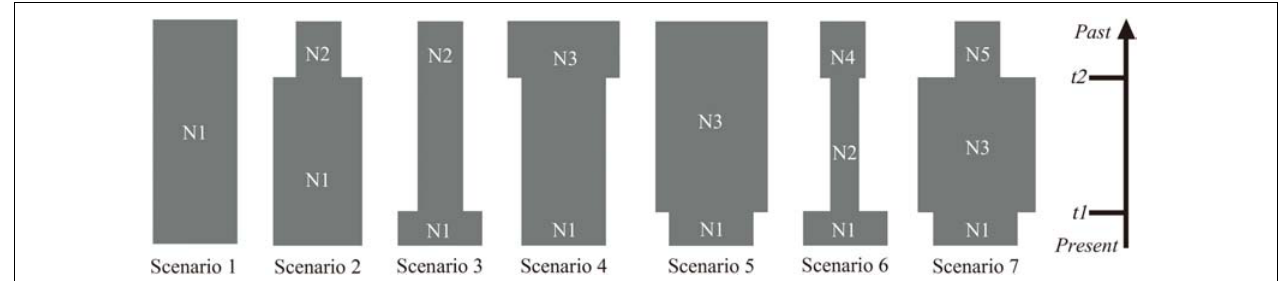
FIGURE 9 | Schematic representation of the seven demographic scenarios (including model parameters) for P. emblica tested by the DIYABC method using the SSR loci. (Scenario 1) constant effective population size (N1); (Scenario 2) an old expansion (N2 to N1, t2); (Scenario 3) a recent expansion (N2 to N1, t1); (Scenario 4) an old bottleneck (N3 to N1, t2); (Scenario 5) an recent bottleneck (N3 to N1, t1); (Scenario 6) an old bottleneck (N4 to N2, t2) followed by a recent expansion that led to current effective size (N2 to N1, t1); and (Scenario 7) an old expansion (N5 to N3, t2) followed by a recent bottleneck (N3 to N1, t1).